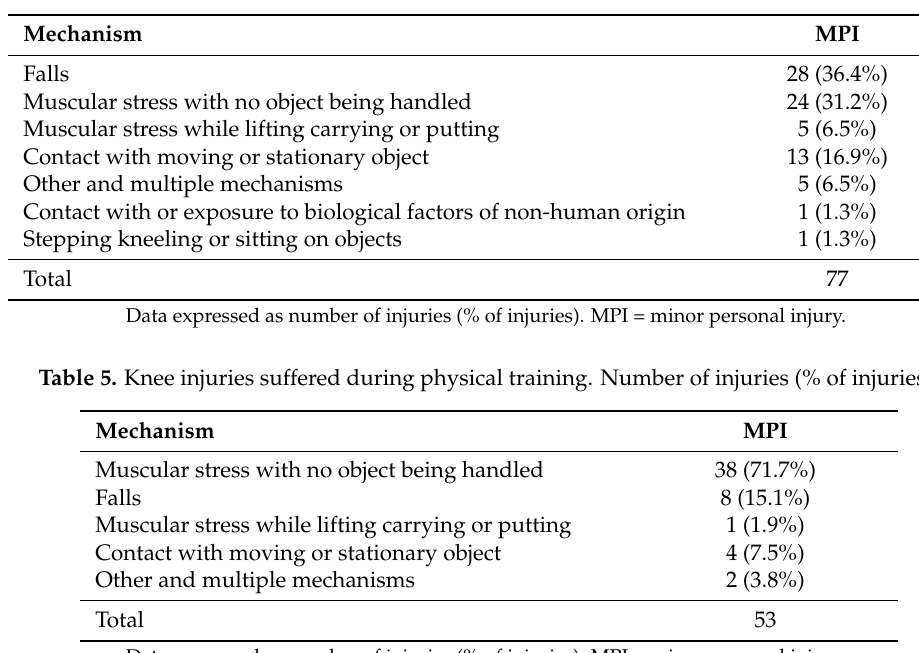
Table 4. Knee injuries suffered during combat training. Number of injuries (% of injuries).